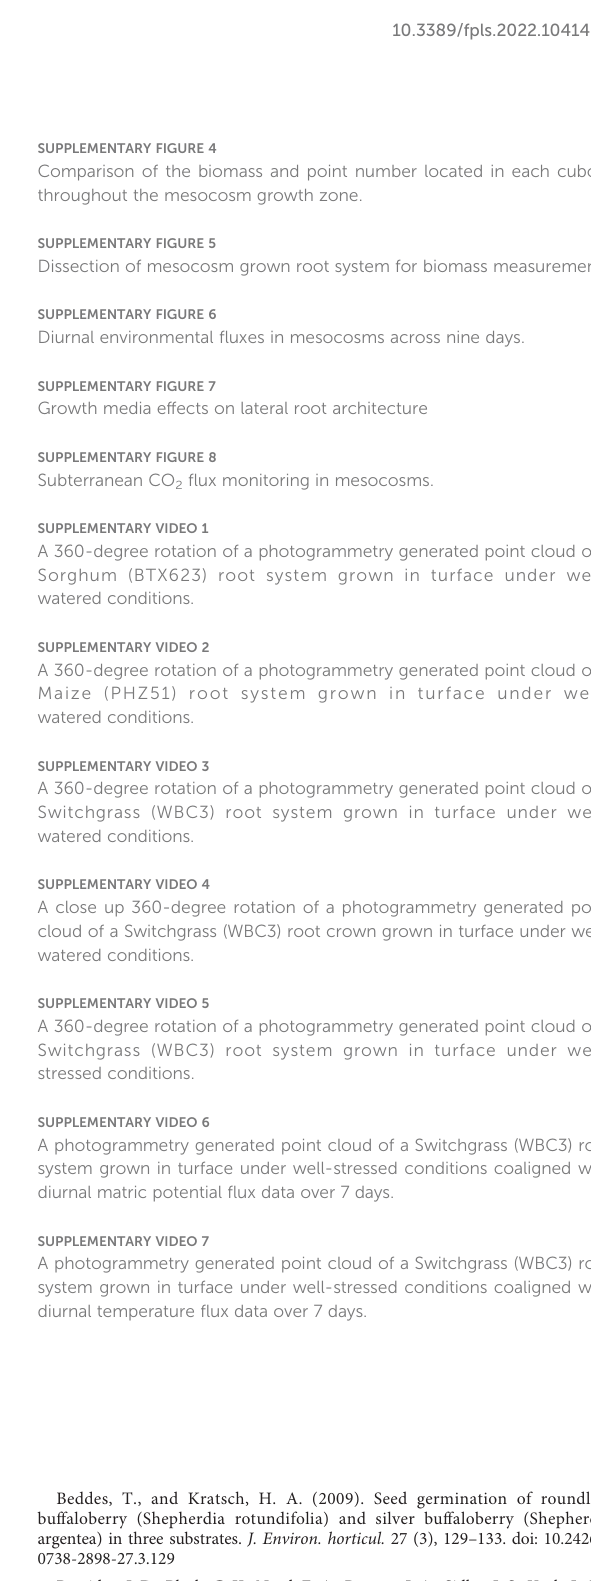
SUPPLEMENTARY FIGURE 3 Manual post-process cleaning of RSA point clouds.